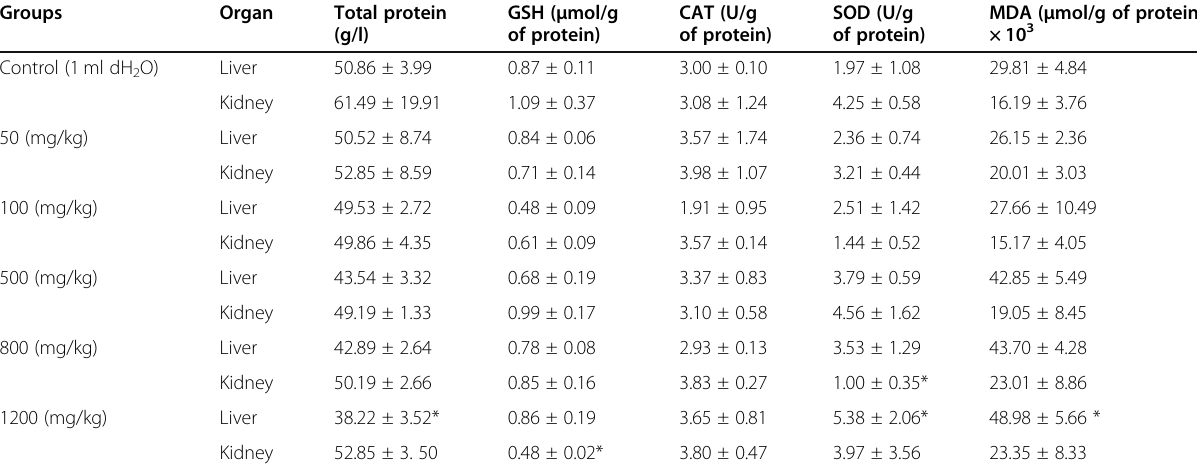
Data are presented as mean±SEM: n=5 determinations. Values with asterisk (*) in the same column indicate significant difference ( p<0.05 ) compared to